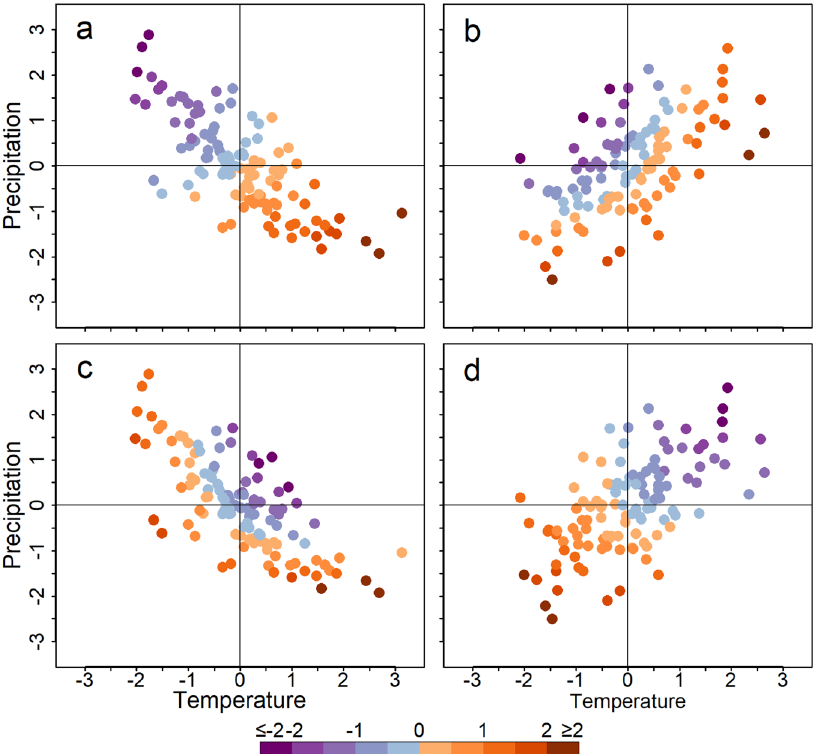
Fig. 1 The relationship between precipitation and temperature and compound indices. a Scatter plot of summer precipitation and temperature anomalies (z-score) with corresponding CWD index in color (see “ Methods ” ). The location is at 97.25°W and 33.75°N from 1901 to 2018. b The same as a but for spring at 84.75°E and 66.75°N. c Same distribution as in a but colored based on the CCD index. d Same distribution as in b but colored based on the CCD